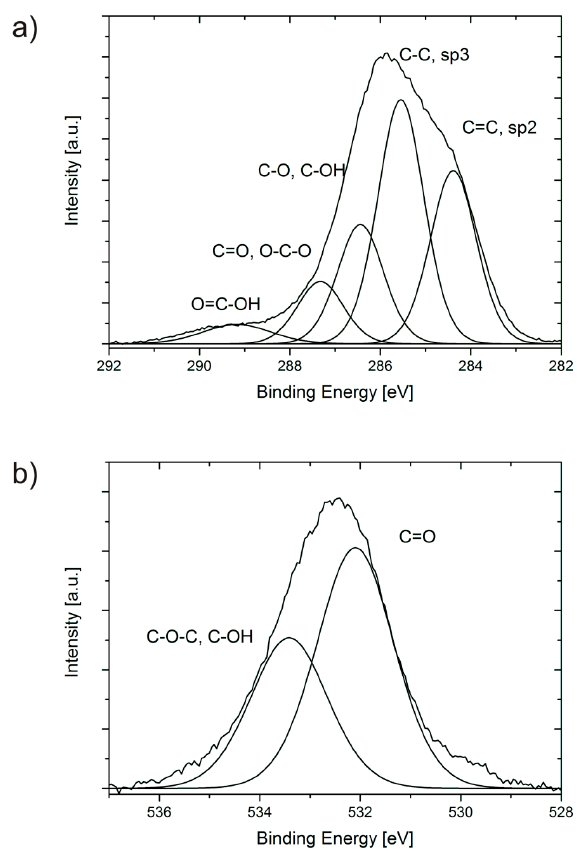
Figure 2. XP spectra of ( a ) C1s signals, and ( b ) O1s signals of the carbon nanofoam.